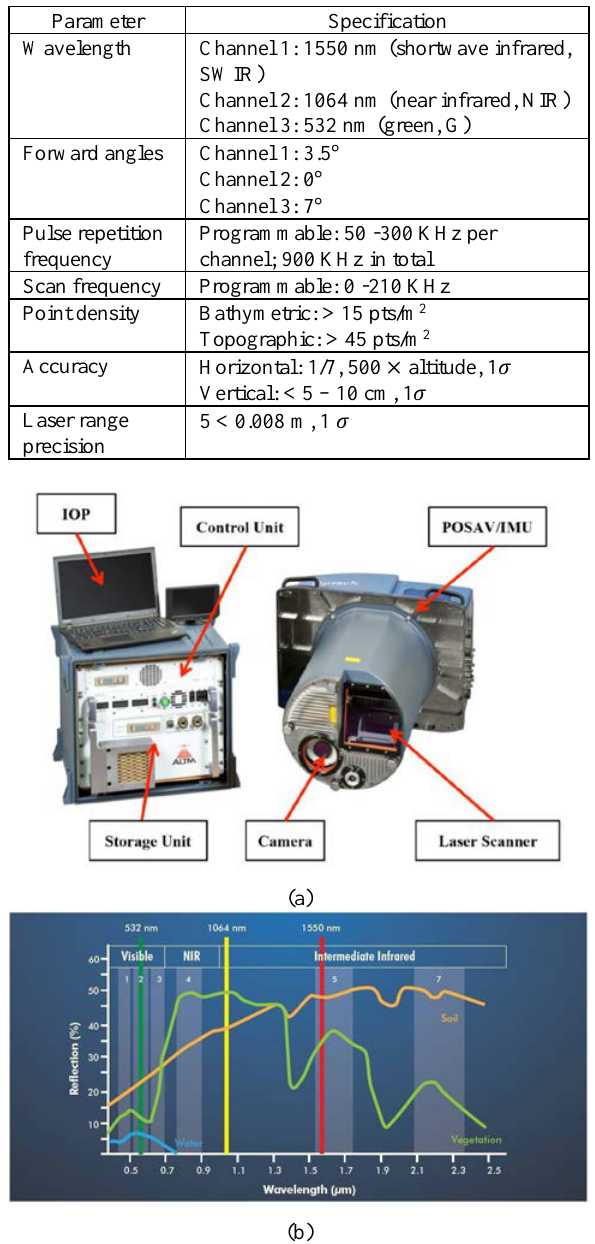
Figure 1. (a): The Teledyne Optech Titan system; (b) Titan laser channels with spectral signatures for selected objects (Teledyne Optech Titan,